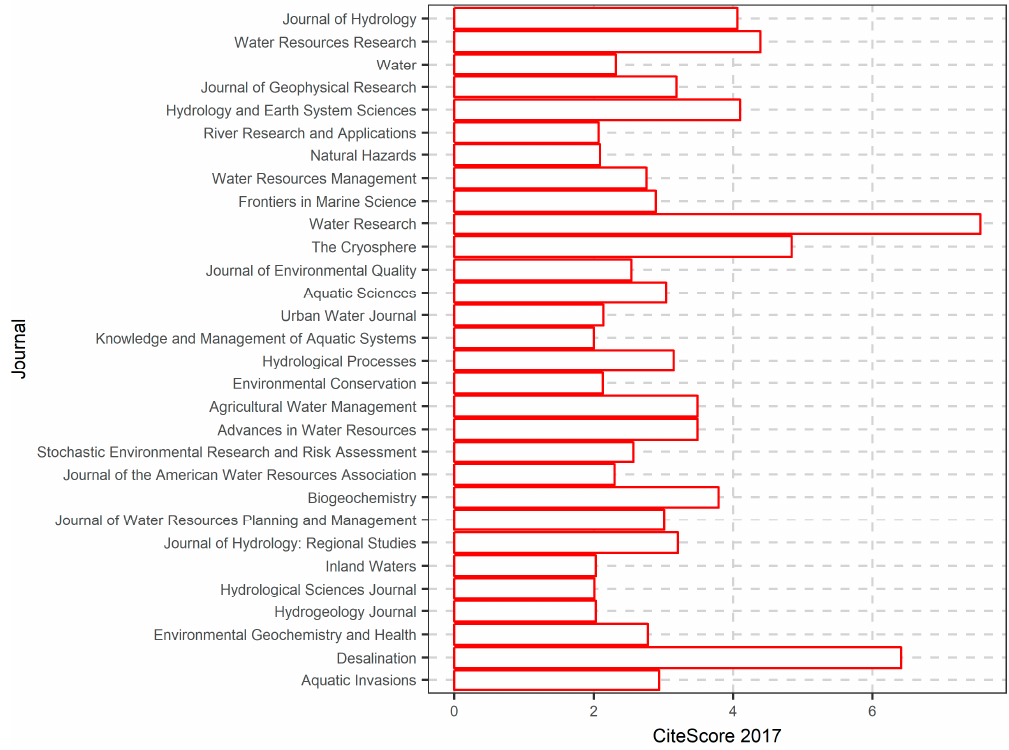
Figure 4. Journal CiteScores where RF-related papers are published. The Journals are ranked in descending order, based on the number of published RF-related papers (see also Figure 3).